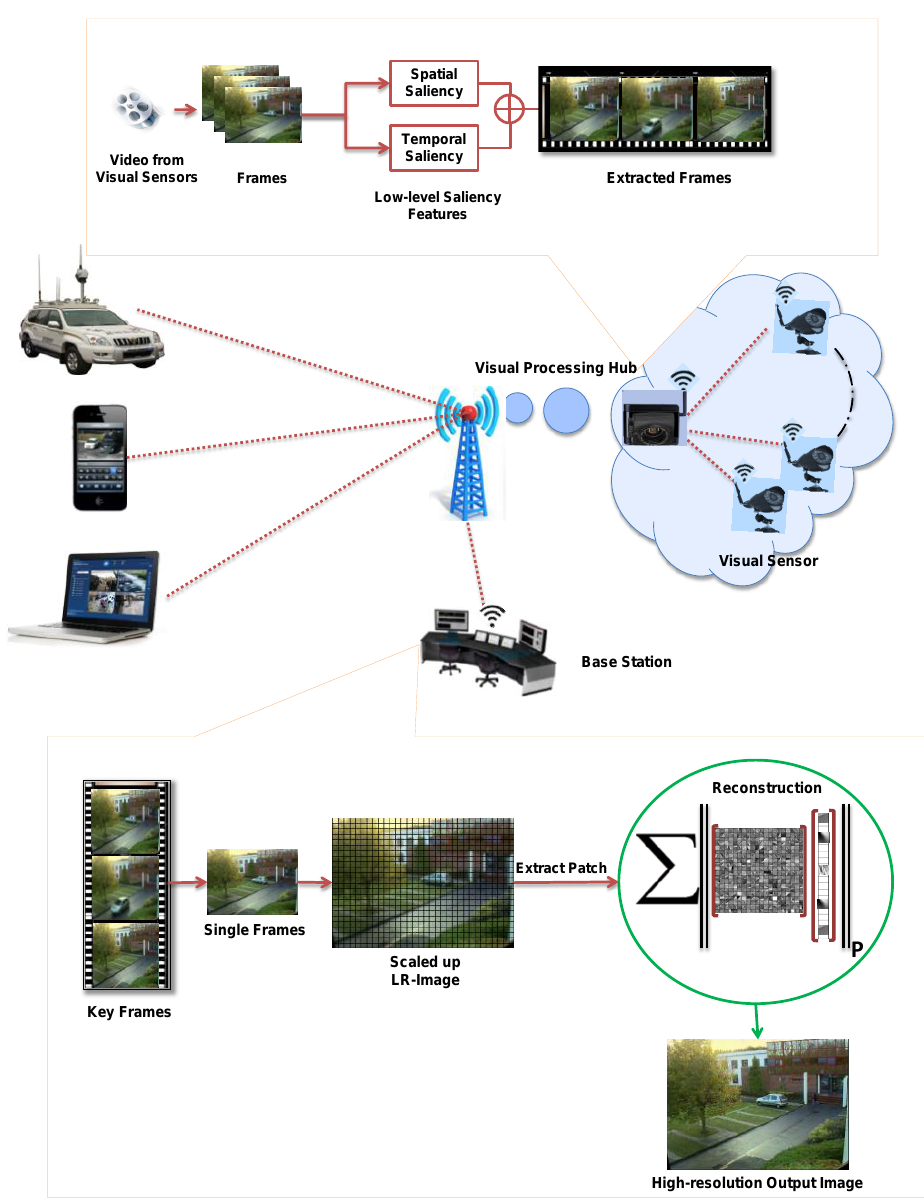
Figure 1. Framework of the proposed